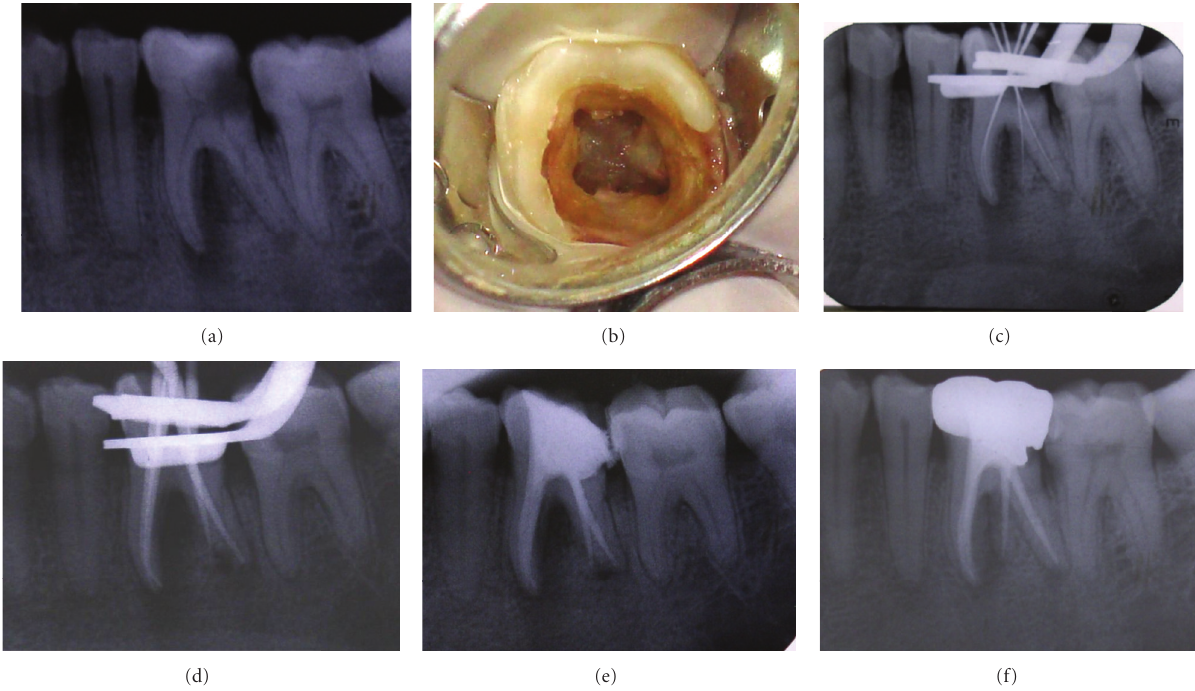
Figure 2: (a) Diagnostic radiograph, (b) access cavity preparation, (c) working length determination, (d) master cone confirmation, (e) postobturation, and (f) eight-month